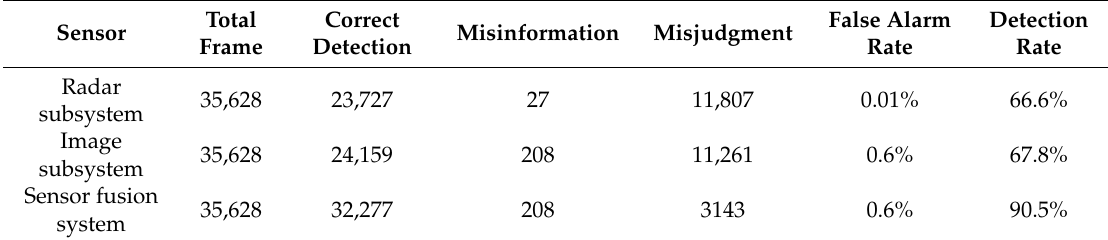
Table 5. Detection results of each